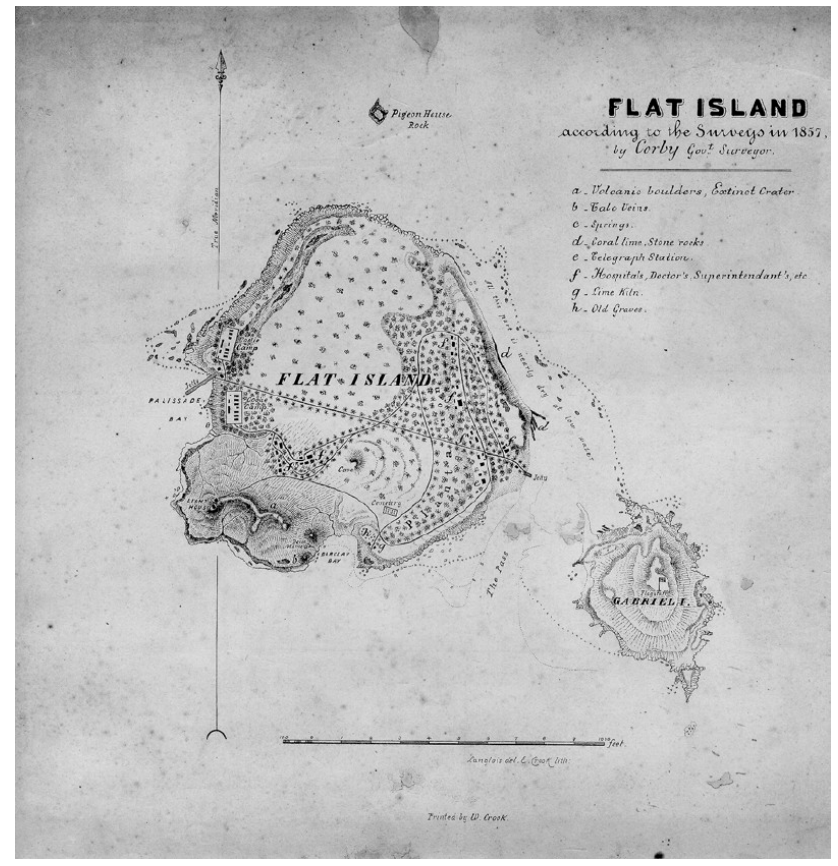
Figure 7. Flat and Gabriel Island: the map by Thomas Corby (1857).